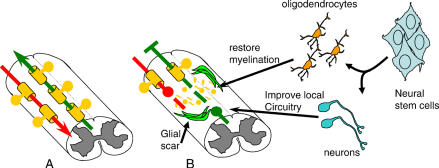
Normal and Injured Spinal Cord(A) Normal spinal cord with examples of ascending (green) and descending (red) pathways.(B) After SCI, degeneration of both descending and ascending axons occurs with glial scar formation and loss of local myelinating oligodendrocytes and grey matter neurons. Stem cells could provide growth factors beneficial to SCI repair, or help replace lost myelin or circuitry.